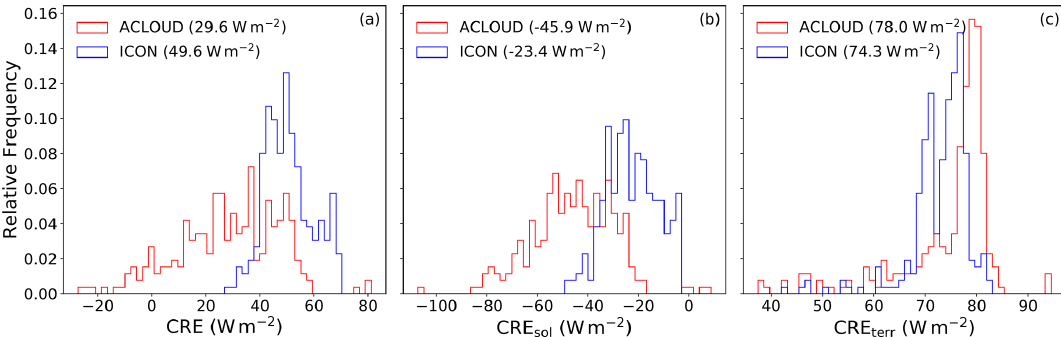
Figure 4. Same as Fig. 3 but for the (a) total, (b) solar, and (c) terrestrial net cloud radiative effect at the